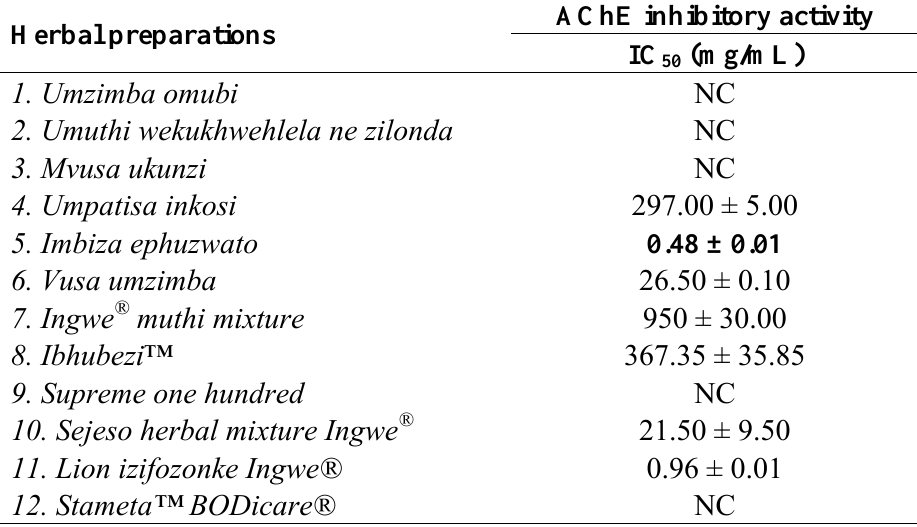
Table 4. AChE inhibitory activity (IC Pietermaritzburg,